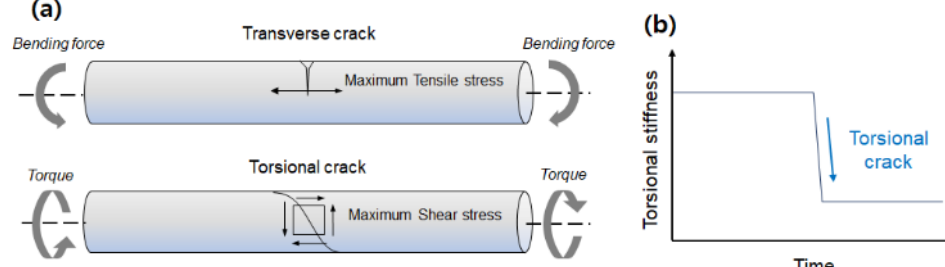
Figure 1. Characterization of fatigue cracks: ( a ) two types of crack propagation: transverse and torsion crack, ( b ) sudden torsional stiffness reduction.